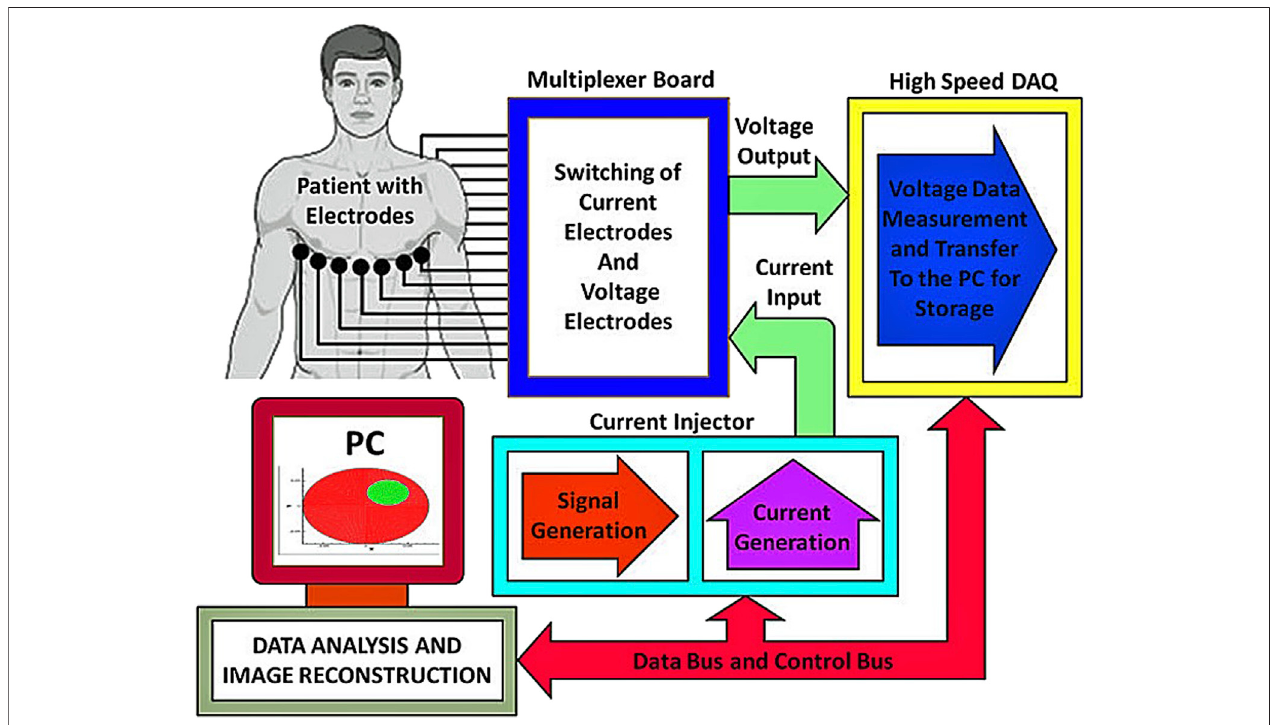
FIGURE 3 | Schematic of an EIT instrumentation system [adapted from Bera and Jampana (2011)]. The main structure of the hardware system is composed of an electrode array, an excitation source, a data acquisition system, an upper computer, and a strobe switch.